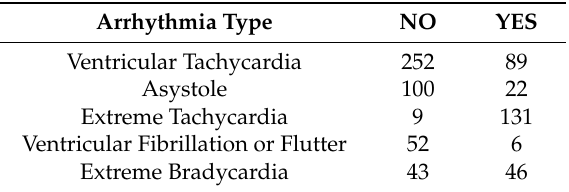
Table 4. Arrhythmia types and alarm distribution used in the 2015 Challenge.